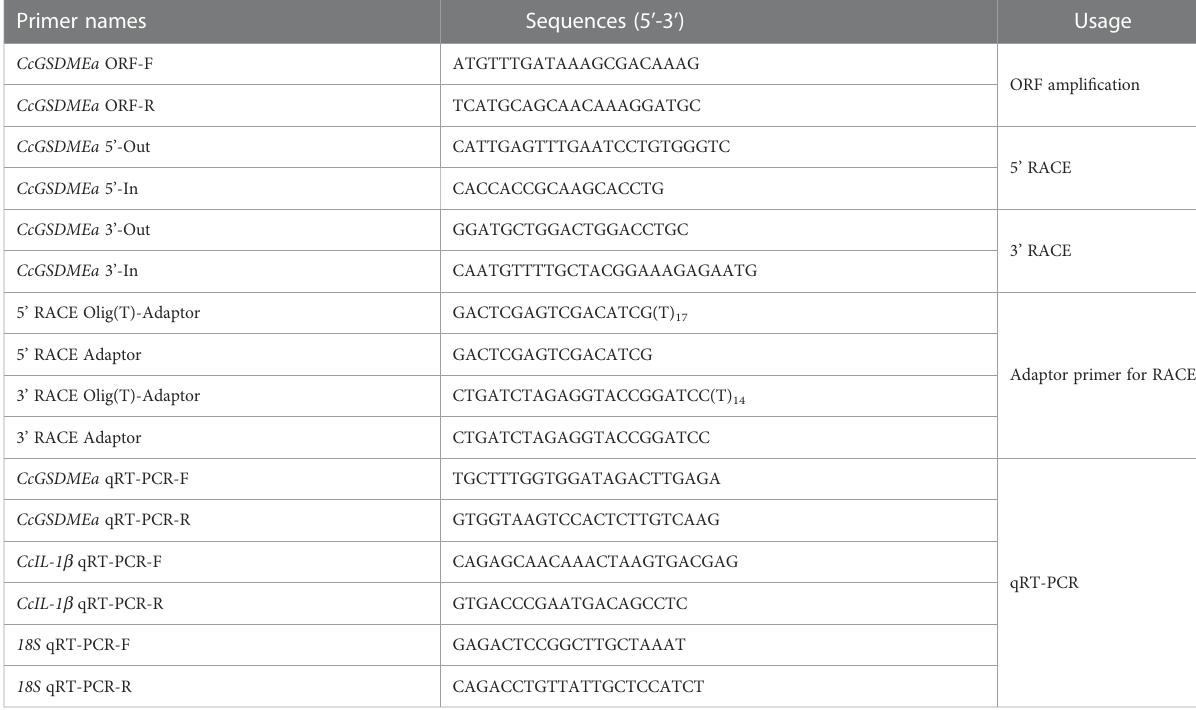
TABLE 1 Primers used for gene cloning and qRT-PCR in this